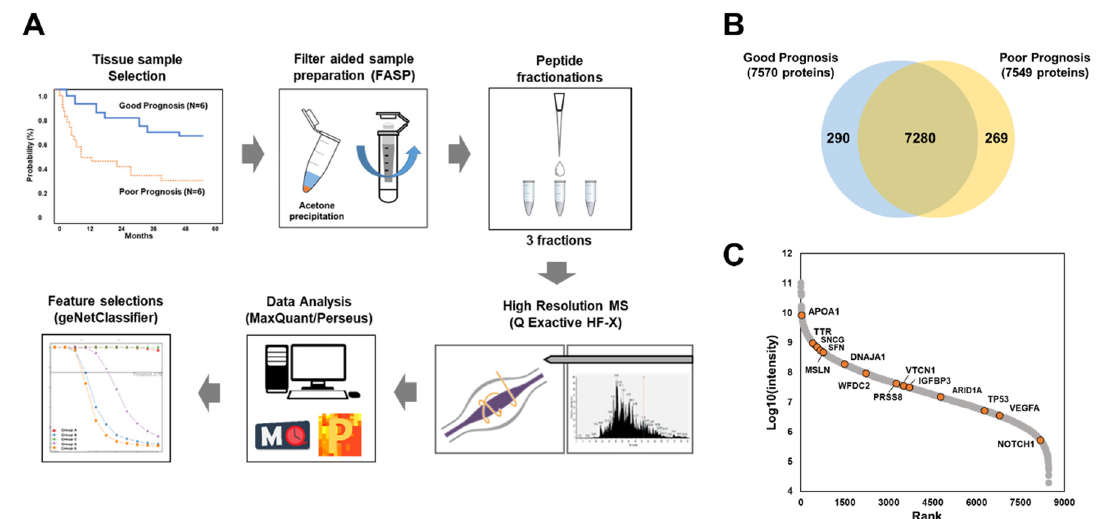
Figure 1. Proteomic analysis of ovarian cancer tissues with respect to survival outcome: ( A ) the protocol for proteomic analysis; ( B ) total number of proteins identified in each group of samples; ( C ) dynamic range of candidate biomarkers for high-grade serous ovarian carcinoma. MS, mass spectrometry.